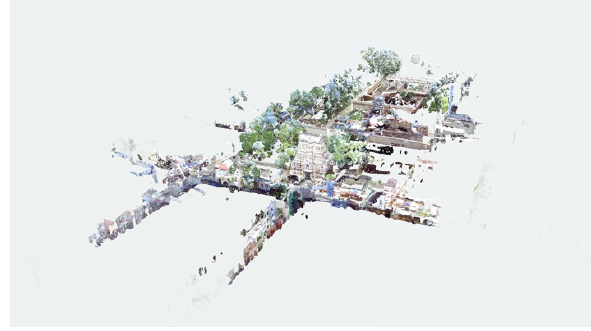
Figure 2. Pointcloud showing Nageshvara temple at Kumbakonam, Tamil Nadu,